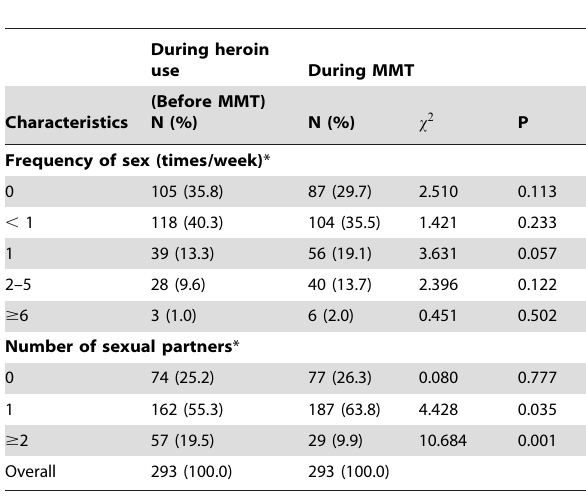
Table 2. Self-reported sexual behavior characteristics of participants before and after